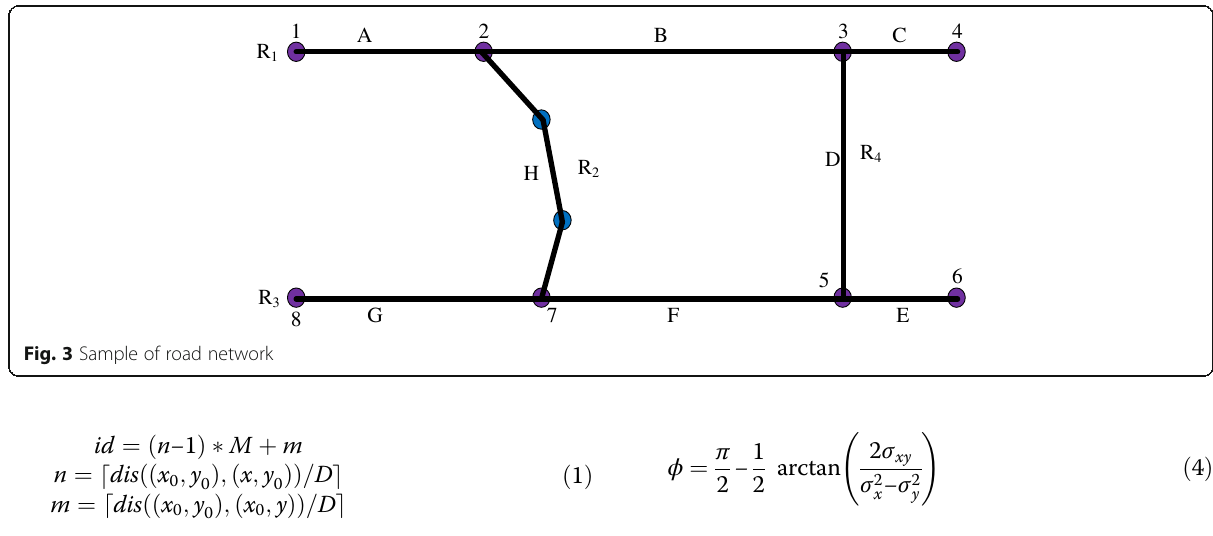
Fig. 3 Sample of road